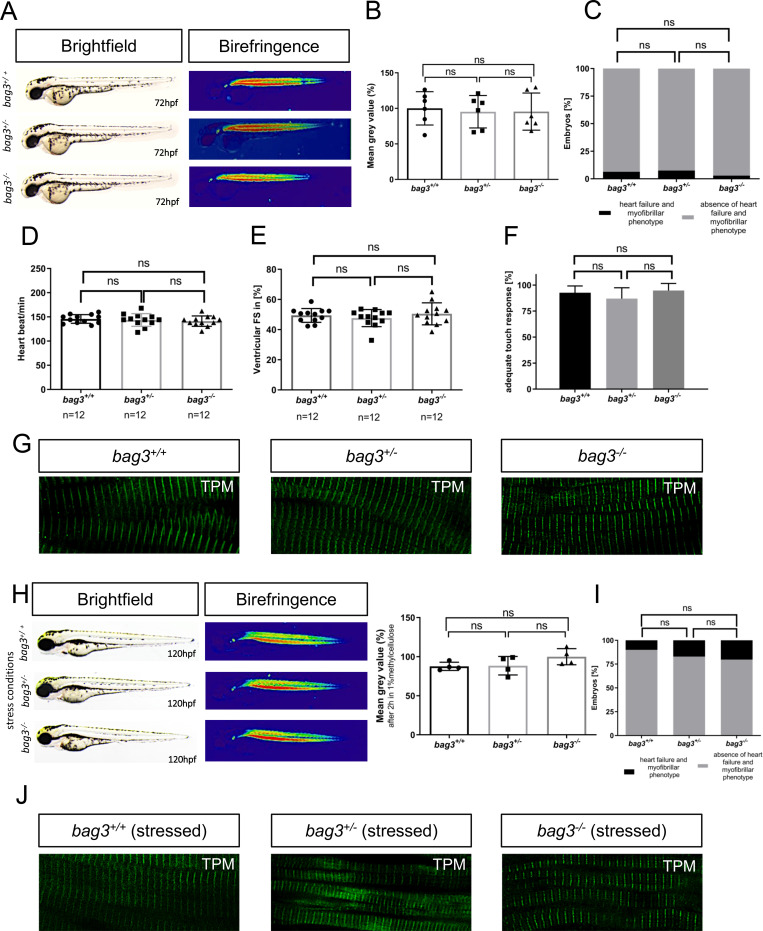
Genetic loss of bag3 does not interfere with heart and skeletal muscle function.(A) Lateral view of brightfield and birefringence images for bag3+/+, bag3+/- and bag3-/- embryos at 72 hpf exhibiting homogenous birefringence signals. (B) Densitometric analysis of birefringence does not report muscle disorganization in bag3-/- embryos. Representative samples are shown (n = 6, One-way ANOVA followed by tukey's multiple comparison analysis, P = 0.9688). (C) Embryos at 72 hpf reveal no myopathic phenotype (N = 3, n = 100, two-tailed value for Fisher´s exact test. bag3+/+ and bag3+/- P = 0.8096; bag3+/+ and bag3-/- P = 0.4949; bag3+/- and bag3-/- P = 0.1925). (D) Heart rate quantification at 72 hpf reveals no impairments under physiological conditions (N = 3, n = 12, mean ± S.D. One-way ANOVA followed by tukey's multiple comparison analysis, P = 0.6026). (E) Quantification of ventricular FS at 72 hpf does not reveal contractile dysfunction (N = 3, n = 12, mean ± S.D. One-way ANOVA followed by tukey's multiple comparison analysis, P = 0.5061). (F) Quantification of the touch evoked assay. bag3-/- embryos reveal no significant difference in responsiveness upon mechanical stimulus (N = 3, n = 90, mean ± S.D. One-way ANOVA followed by tukey's multiple comparison analysis, P = 0.7851). (G) Immunostaining of bag3+/+, bag3+/- and bag3-/- embryos at 72 hpf, with sarcomeric Tropomyosin, showing no muscle fiber disruptions. (H) Brightfield and birefringence images of mutant embryos at 120 hpf under stressed conditions reveal no myopathic phenotype, which was confirmed by densitometric analysis of birefringence signals. Representative samples are shown (n = 4, One-way ANOVA followed by tukey's multiple comparison analysis, P = 0.1824). (I) Embryos, under stressed conditions, do not develop myopathic phenotype (N = 4, n = 50, two-tailed value for Fisher´s exact test. bag3+/+ and bag3+/- P = 0.6050; bag3+/+ and bag3-/- P = 0.8320; bag3+/- and bag3-/- P = 0.8582). (J) Immunostaining of bag3+/+, bag3+/- and bag3-/- embryos at 120 hpf under stressed conditions (2 hours in 1% methylcellulose), with sarcomeric Tropomyosin, showing no muscle fiber disruptions.